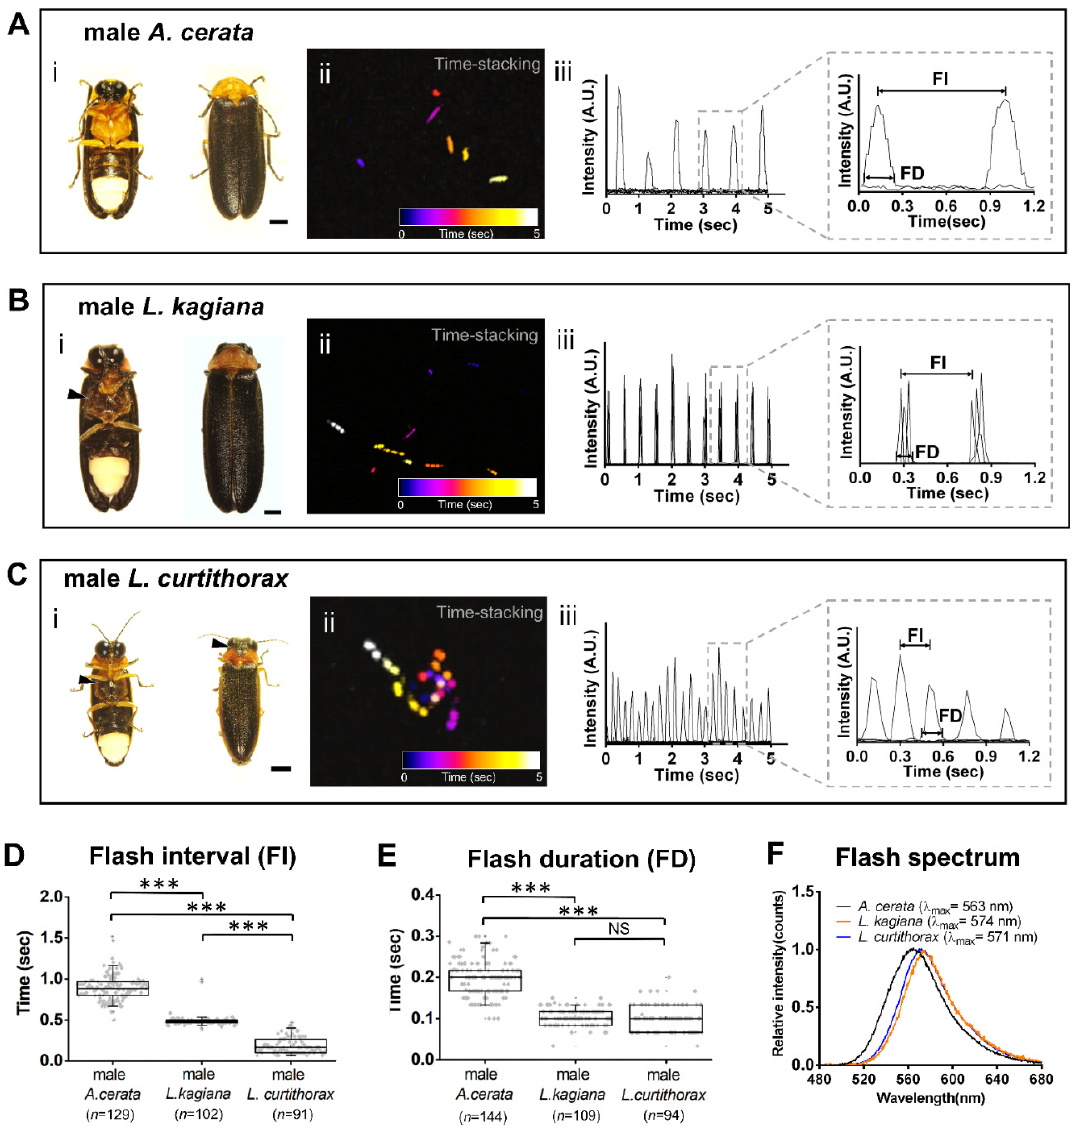
Figure 2. Comparative morphological and luminous features of adult males of A. cerata , L. kagiana , and L. curtithorax . ( A – C ) The exteriors and the flash patterns of the three species in flight. Each box gives a ( i ) ventral (left) and dorsal (right) view of the representative individual, ( ii ) a time-stacking (5 s) image and ( iii ) a timing diagram of the flash pattern while flying, and the magnifying panel denotes the measurement of flash interval (FI) and flash duration (FD). In ( i ), the arrows indicate the morphological marks that are distinct from other species. In ( ii ), the pseudo-color flashes correspond to a color code denoting the chronological order of the flashes. ( D , E ) Comparative boxplots of FI (or FD) patterns of male adults while flying. The FI (or FD) data points (gray spots) in each boxplot were obtained by continuous flash signals (lasting 5 s) from five to ten distinct individuals. ( F ) Comparative flash wavelength spectra. λ max was determined and averaged from three distinct individuals of each species. ‘ n ’ represents total FI (or FD). Significance: *** p < 0.001. NS: no significance. A.U.: arbitrary units. Scale bar: 1 mm.